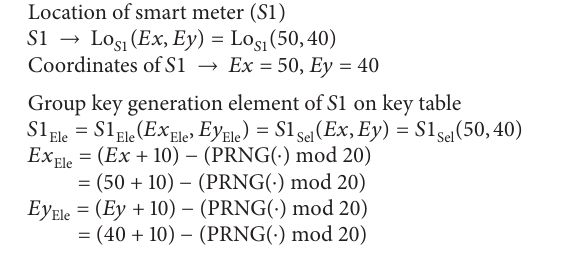
Group key generation element of 𝑆1 on key table 𝑆1